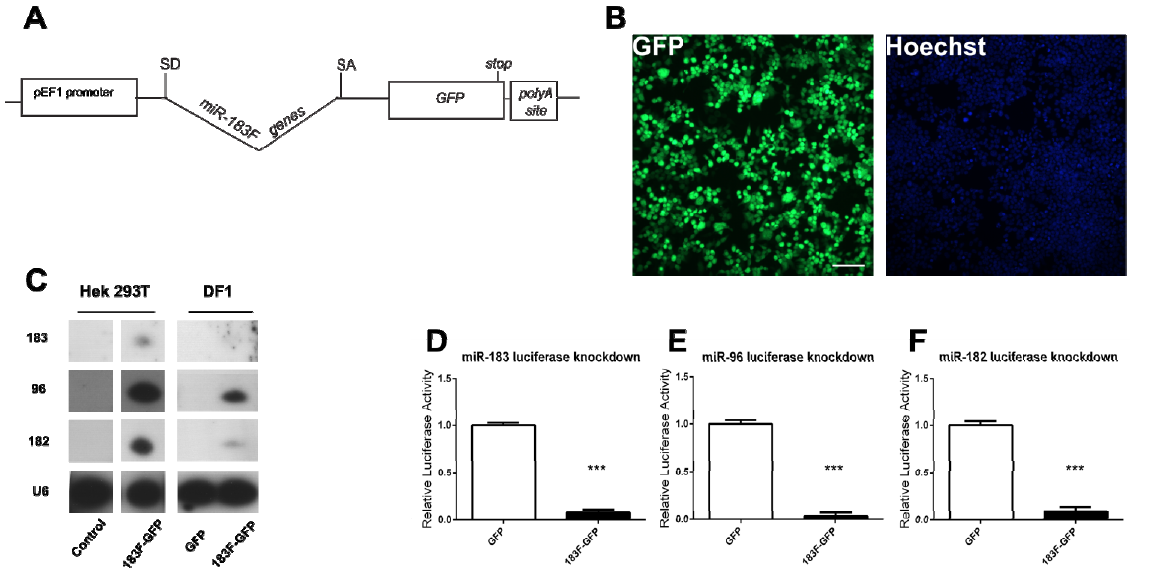
Figure 5. Plasmid containing miR-183 family and the GFP gene produces functional miRNAs and GFP protein in HEK293T cells. ( A ) Vector design of p183F-GFP; ( B ) Visualization of GFP in cells transfected with p183F-GFP. Scale bar = 100 microns; ( C ) The miR-183 family is expressed from p183F-GFP in mammalian and avian cells. Cells transfected with p183F-GFP showed expression of mature miR-183, -96, and -182. Control (untransfected cells) and pGFP transfected cells exhibit no detectable miRNA. U6 levels serve as the loading control; ( D – F ) Luciferase activity is decreased by expression of miRNAs from p183F-GFP expressing vector; ( D ) Cells co-transfected with p183F-GFP and the psiCHECK-2 reporter containing sites complementary to miR-183 show a significant decrease in luciferase activity compared to cells co-transfected with the pGFP and reporter; ( E ) and ( F ) show results of experiments similar to ( D) except the reporter contained different complementary binding sites: 96 for ( E ) and 182 for ( F ). Each bar represents mean (±standard error) for each group. Each experiment was replicated at